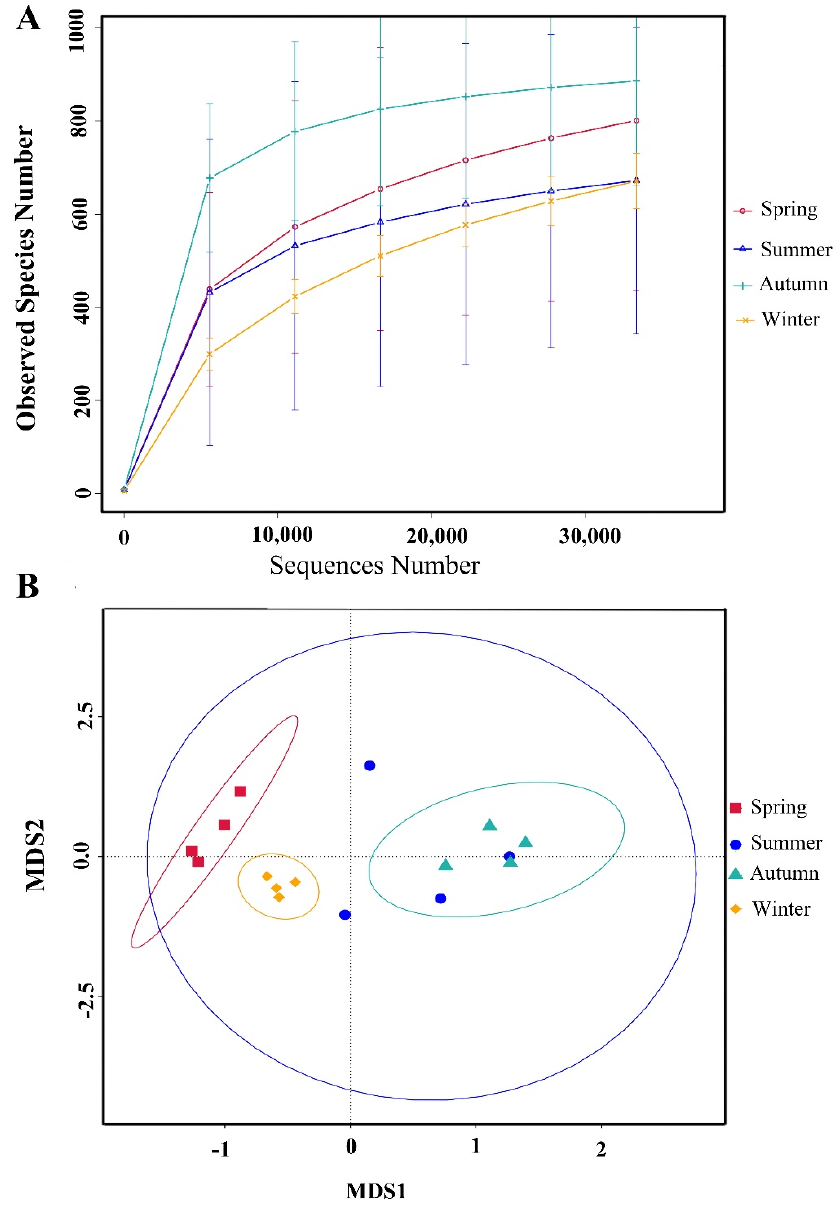
Figure 2. The rarefaction curve and NMDS analysis of all samples in different seasons. ( A ) Rarefaction curve analysis showing the relationship between sequences number ( x -axis) and observed species number ( y -axis). ( B ) NMDS plot of Bray–Curtis distances among four seasonal samples based on OTUs for bacteria.